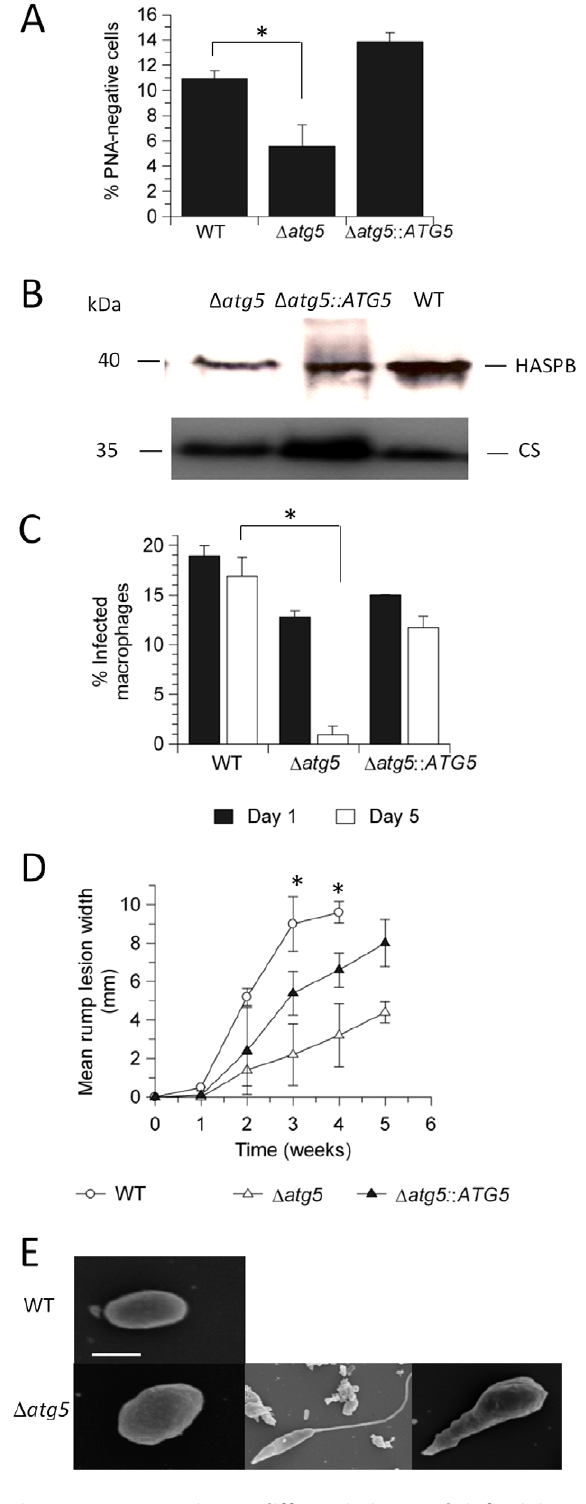
Figure 7. Promastigote differentiation and infectivity. (A) Proportion of metacyclic promastigotes in stationary phase cultures, assessed using the PNA assay. Values shown are the means 6 SD from three independent experiments. *, differed significantly (p , 0.05). (B) Western blot analysis of extracts of 10 7 promastigotes at stationary phase of growth probed with a -HASPB. a -Cysteine Synthase was used as a loading control [56]. (C) Infectivity and survival of promastigotes in peritoneal macrophages in vitro , infected at a ratio 5:1, with